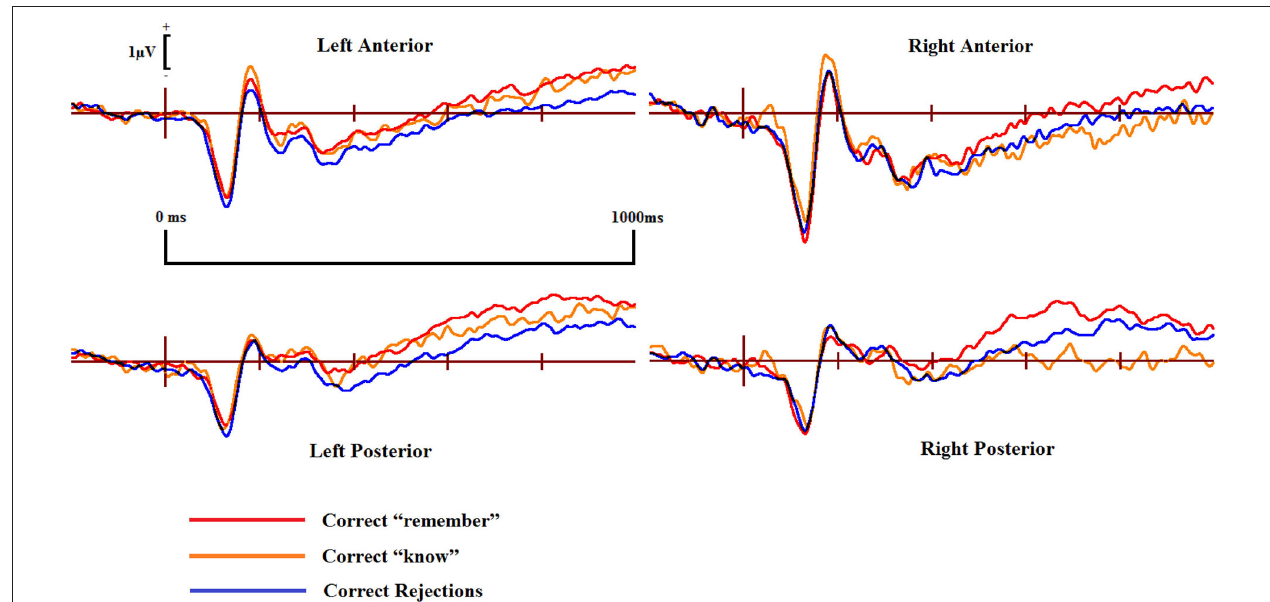
FIGURE 5 | ERPs of correct “remember” and “know” responses compared to correct rejections from the four scalp locations for the controls .